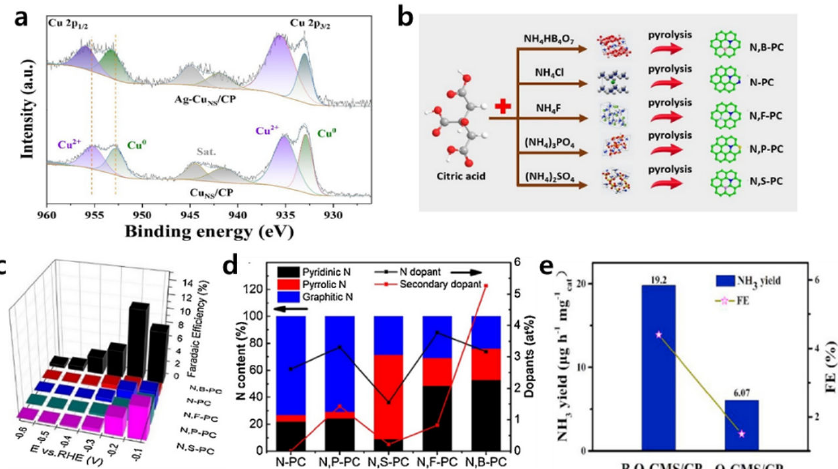
Figure 2. ( a ) Cu 2p XPS of Ag-Cu NS /CP and Cu NS /CP. Reproduced with permission [34]. Copyright 2021, Elsevier B.V. ( b ) Scheme of the heteroatoms co-doped porous carbons. ( c ) FEs of the heteroatoms co-doped porous carbons and N doped porous carbon. ( d ) Contents of total N and specific N species with secondary dopants. Reproduced with permission [37]. Copyright 2020, Elsevier B.V. ( e ) NH 3 production rate (NH 3 yield rates) and FEs of B,O-CMS/CP and O-CMS/CP. Reproduced with permission [15]. Copyright 2020, Elsevier